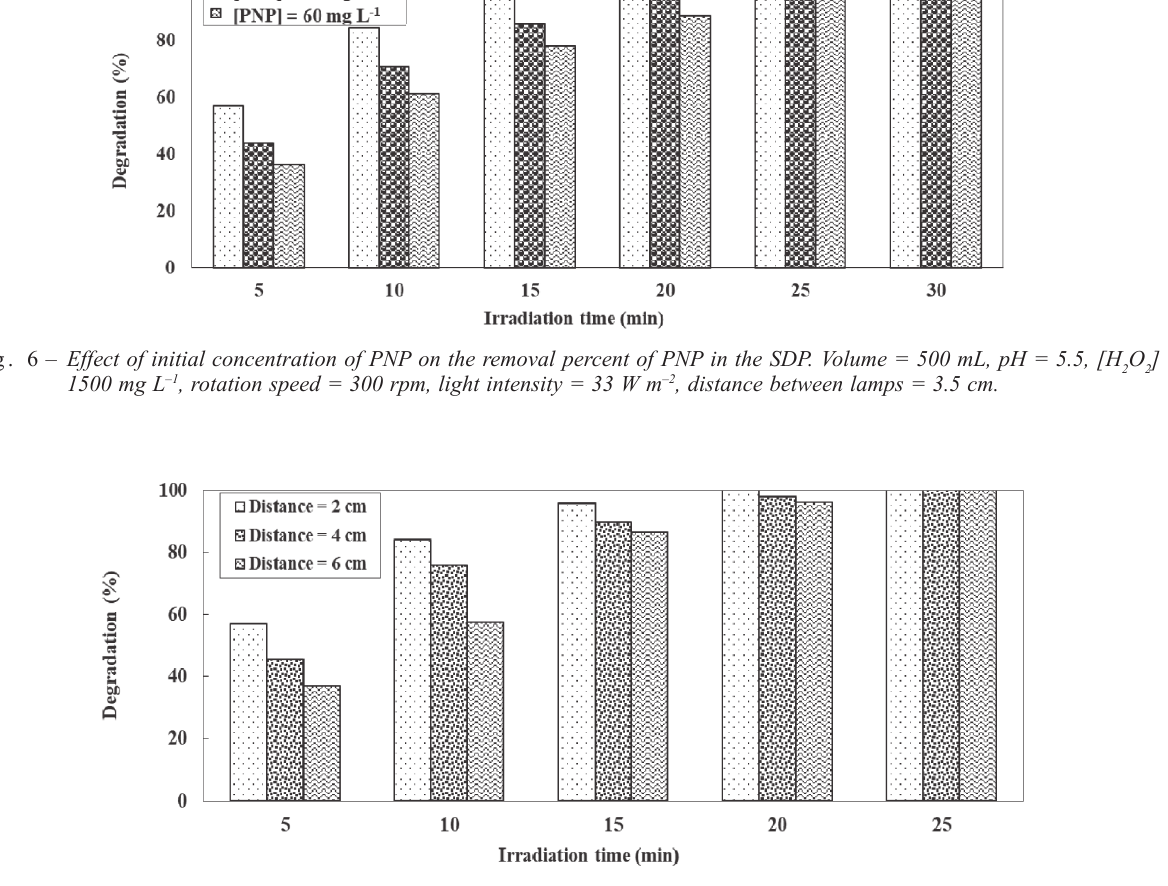
Fig. 7 – Effect of lamps distance from the surface of the spinning disc (light intensity) on the removal percent of PNP in the SDP. [PNP] = 20 mg L –1 , volume = 500 mL, pH = 5.5, [H distance between lamps = 3.5